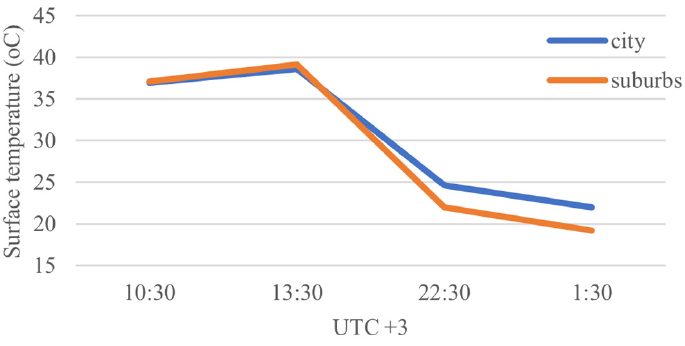
Figure 4. Comparison of average surface temperature between city and suburbs over the day.